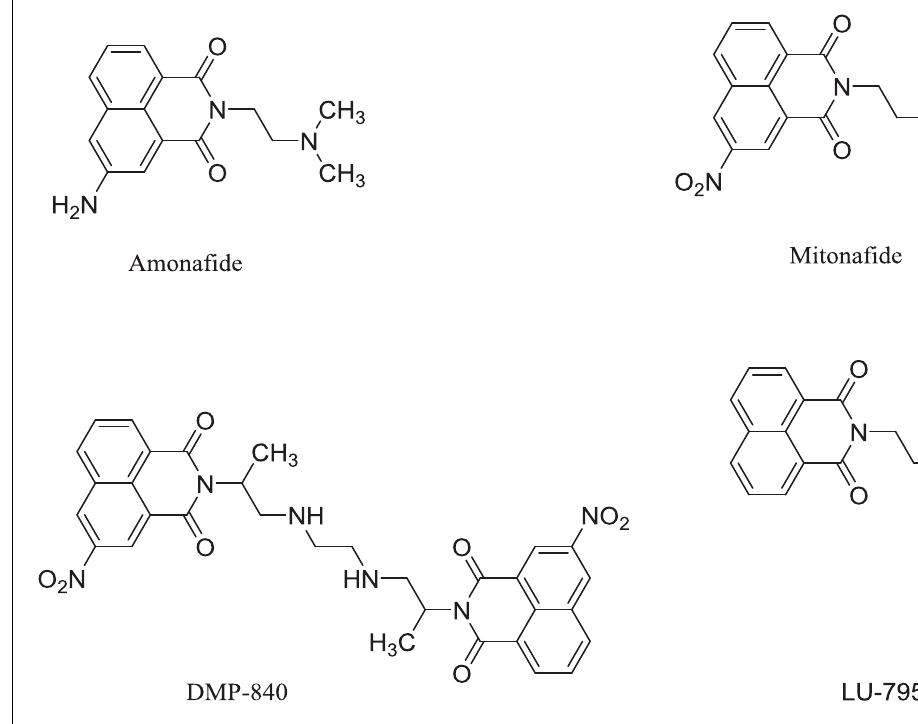
FIGURE 1 | The reported naphthalimide derivatives.